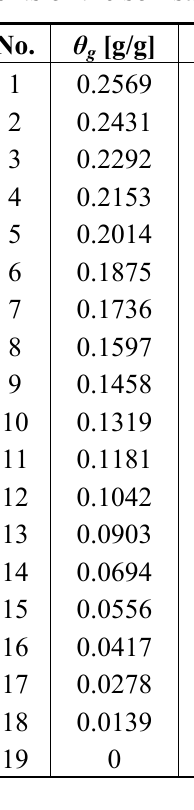
and effective conductivity σ of the humogley soil, r e